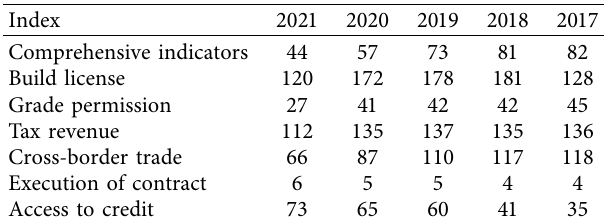
Figure 1: The impact of price-based policies on the financial benchmark rate of return of the investment industry in the past five years. Table 1: Overview of investment comprehensive evaluation en- vironment of the free trade port.